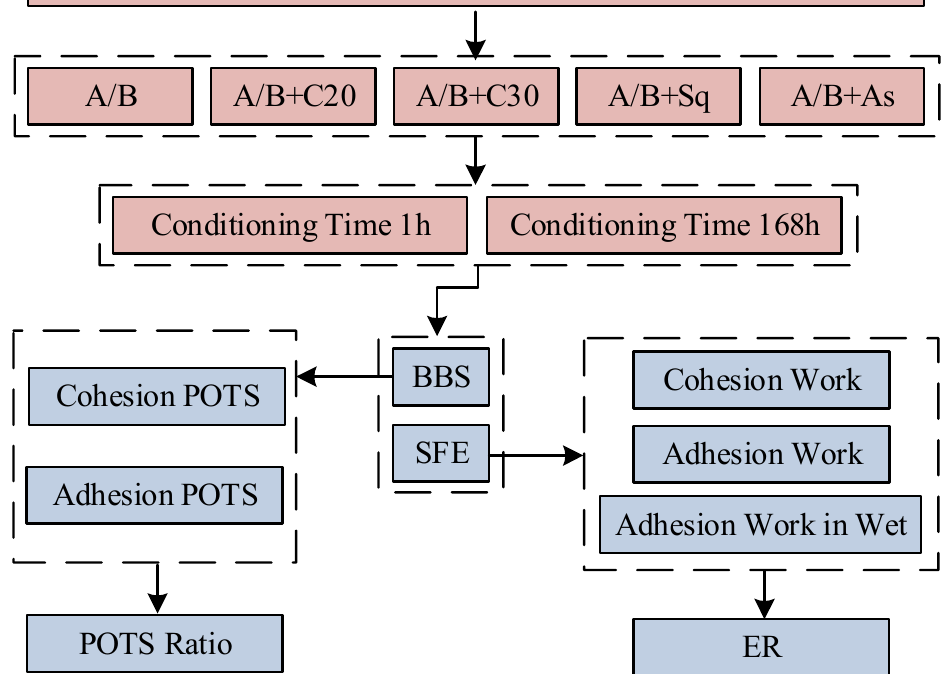
Figure 5. Flow chart of test scheme. Note: In this figure, cohesion POTS, adhesion POTS and the POTS ratio are the moisture sensitivity parameters and indices of the BBS test, respectively. Cohesion work, adhesion work in wet and ER are the moisture sensitivity parameters and indices of the SFE test, respectively.